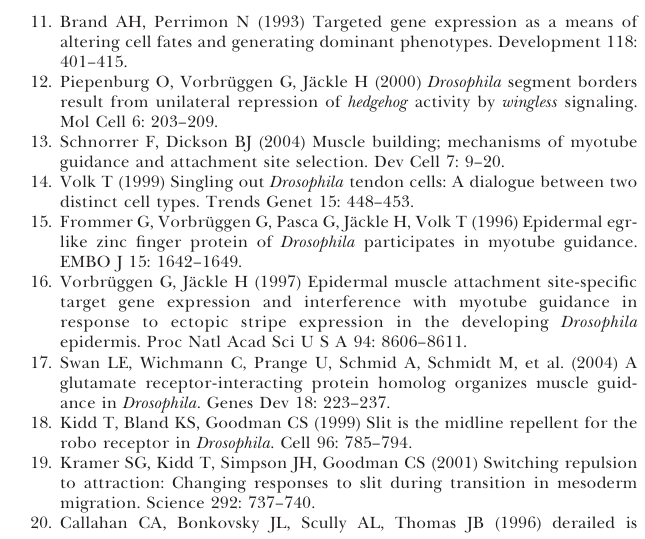
Table S1. Description of the Tested Insertion Lines The lines are ordered according to their names (Line). DG-EP denotes lines that carry the P f Mae-UAS.6.11 g -element whereas HD-EP stands for lines that are generated by mobilization of the modified EPg -element. The chromosome arm (Arm), orientation (Strand), and position according to D. melanogaster genomic sequence release 3 (Position) are indicated. The 5 9 sequence tag (forward strand) for each insertion line is listed (Sequence). Table S2. Insertion Lines Available from the Bloomington Stock Center The lines are ordered according to the name under which they will be